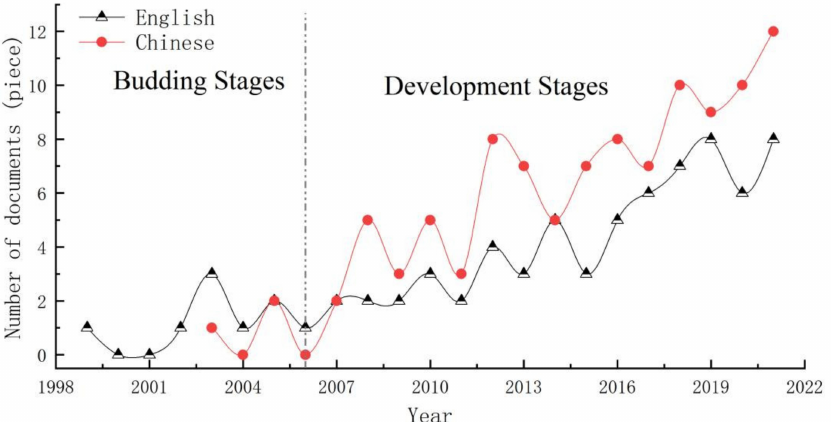
Figure 2. Grassland ecosystem vulnerability study stages: (1) statistics on the vulnerability and resilience of grassland ecosystems in each year; (2) based on the CNKI, WOS, and Google Scholar database retrieval and screening of the literature quantity and research content, the division of the research into stages (emergence and development